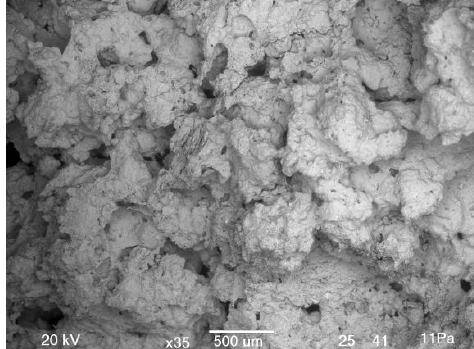
Figure 12. SEM micrograph of AAF prepared with 40 g of mixture ζ 0 , 50 g of precursor, 0.1% of Al, 1% of Na-dodecyl sulphate.